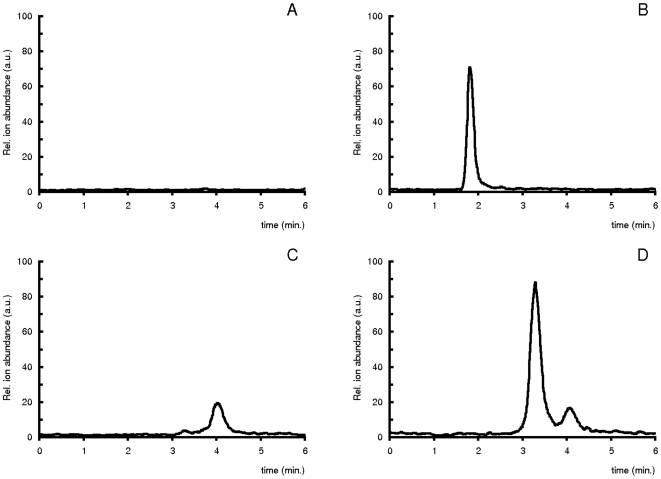
Multiple Reactant Monitoring (MRM) chromatograms of quenched VLCAD assay samples.C16:OH-CoA, m/z 1022.4 → 515.2 (A and B) and C16:1-CoA, m/z 1004.4 → 497.2 (C and D) after 0 (A and C) and 5 (B and D) min. of incubation.